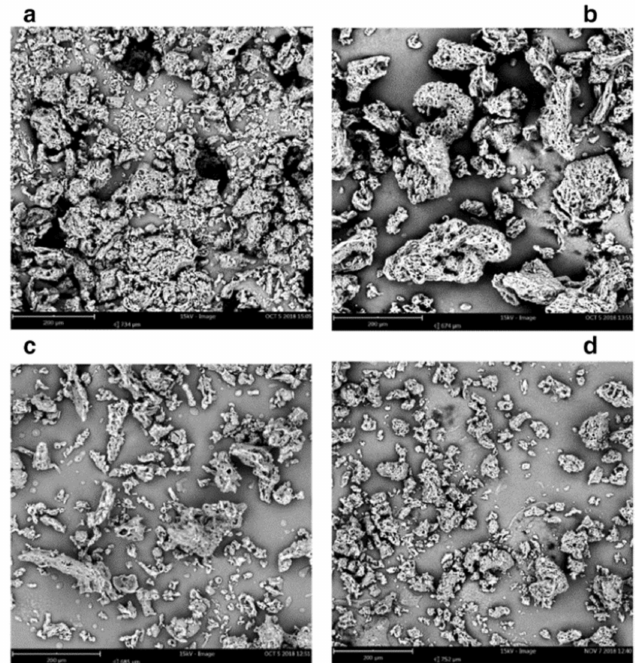
Figure 2. Scanning electron micrographs of microparticles of oils recovered from brewer’s spent grain were encapsulated in polyethylene glycol by PGSS. From ( a – d ) increased processing pressure: ( a ) 10 MPa, ( b ) 20 MPa, ( c ) 30 MPa, ( d ) 35 MPa